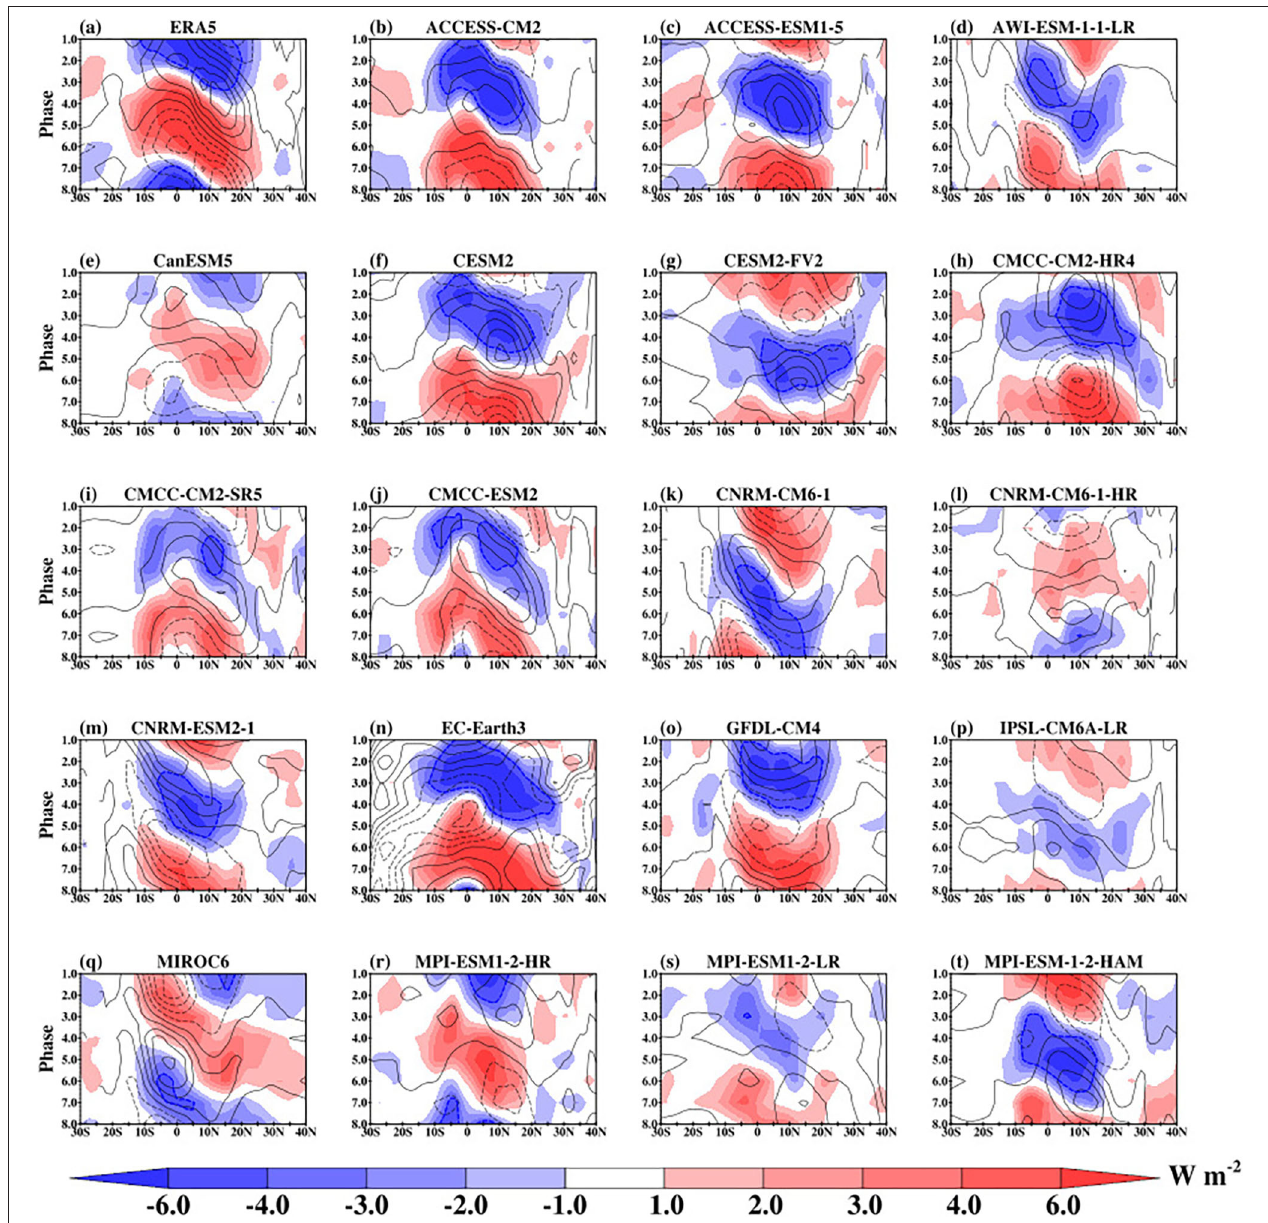
FIGURE 9 | ERA5 (a) and CMIP6 models (b–t) phase-latitude Hovmöller plot of composite May-October 30–60-day OLR (shaded) and U850 (contour) anomalies averaged between 80 ◦ E and 100 ◦ E.